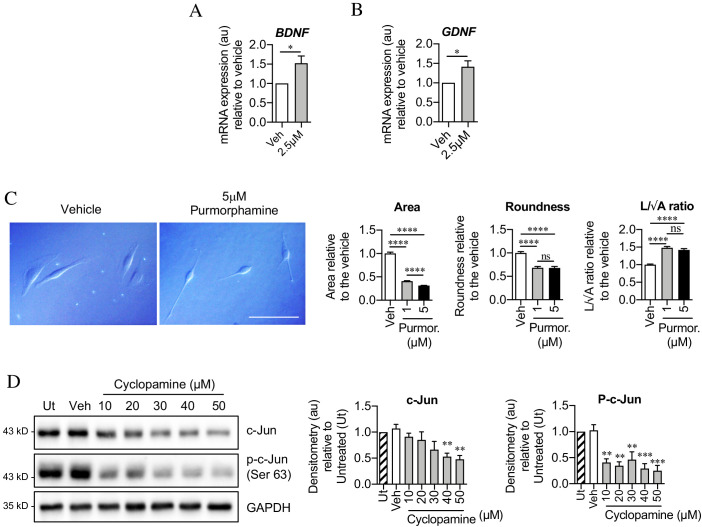
Sonic hedgehog plays a role in c-Jun activation in Schwann cells via autocrine signaling.(A, B) qPCR showing mRNA expression of (A) Bdnf *p=0.0314 and (B) Gdnf *p=0.0382 in Schwann cell cultures incubated for 48 hr with SAG. Data normalized to vehicle. Unpaired Student’s t-tests. n = 4 for each condition. (C) Differential interference contrast (DIC) microscopy showing changes in Schwann cell morphology after 48 hr incubation with purmorphamine (DMSO vehicle). Scale bar: 50 µm. Graphs depict changes in cell area, roundness and length/√area following incubation with purmorphamine, demonstrating enhancement of elongated morphology. One-way ANOVAs with Tukey’s multiple comparison test ***p<0.001. n = 3, each experiment involving measurement of 100 cells per condition. (D) Representative Western blots showing c-Jun and phosphorylated c-Jun in cultured Schwann cells after 48 hr incubation with cyclopamine alone (DMSO vehicle). The graphs show quantitation of the blots. Data are normalized to vehicle. One-way ANOVA with Dunnet’s multiple comparisons test; **p<0.005; ***p<0.001. n = 3. All numerical data represented as means ± SEM.